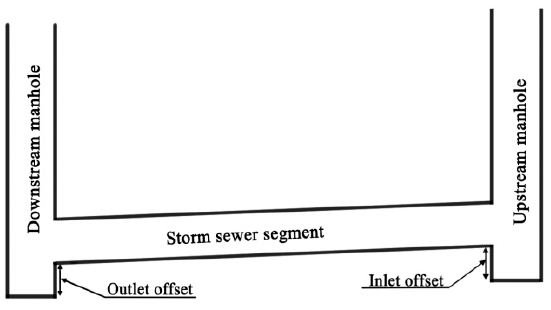
Figure 1. Illustration of inlet and outlet offset.